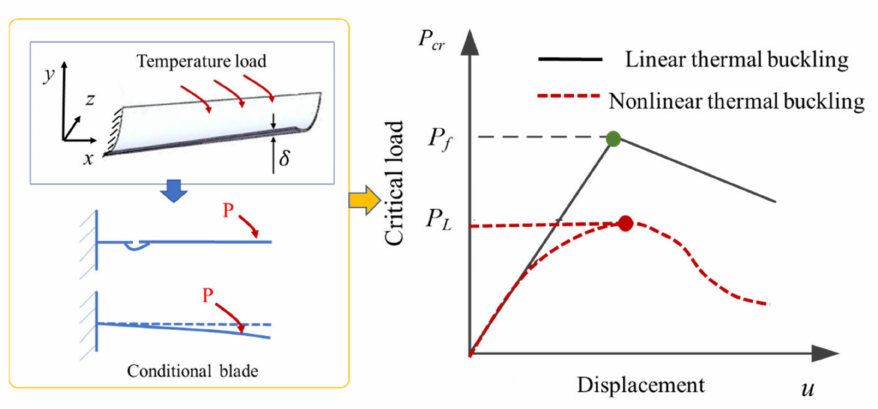
Figure 3. The critical load of linear and nonlinear buckling